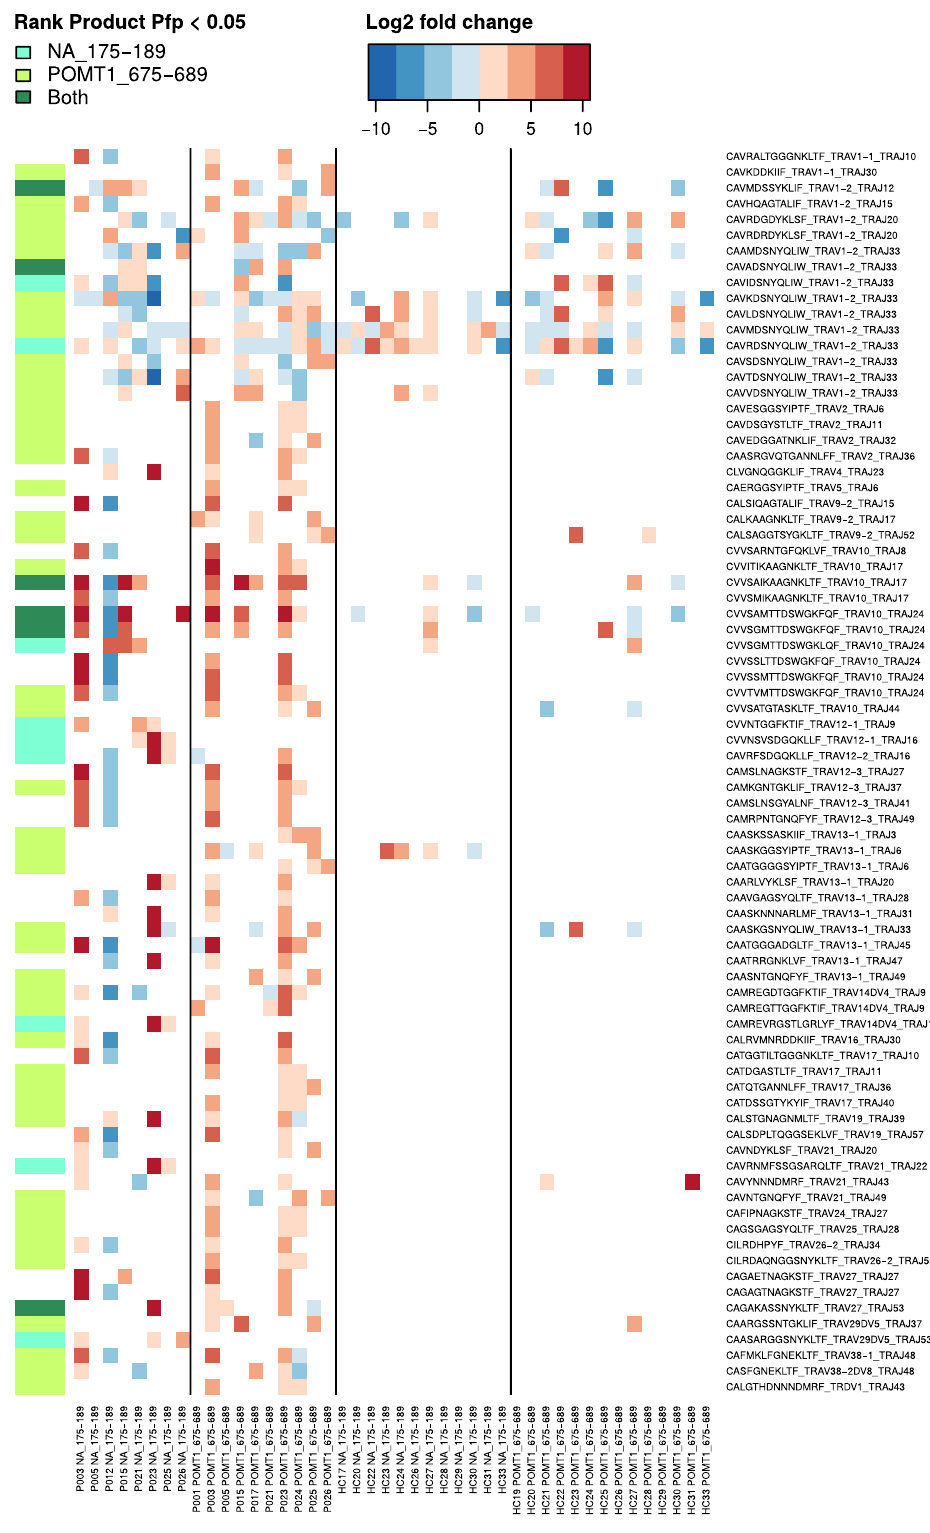
Fig. 8 TCR α chain sequencing of peptide-stimulated PBMCs from Pandemrix-associated NT1 patients. TCR α chains (TRA) were sequenced from the same RNA samples as used for RNA sequencing. P: patient; HC: healthy control. Displayed are TRA clonotypes that were upregulated in ≥ 3 NT1 patient samples, based on fold changes between peptide- (NA 175 – 189 - or POMT1 675 – 689 -) treated and medium control samples from the same participant in data normalized by downsampling (heatmap). Statistical signi fi cance on the group level (NT1 patients only; Rank products test; proportion of false positives <0.05) is indicated on the left side